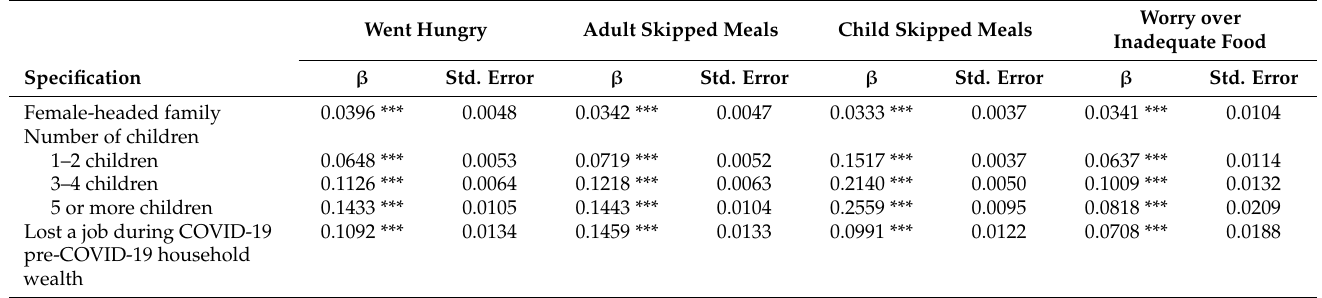
Table 2. Relationship between household structure and food insecurity outcomes during the pan- demic in